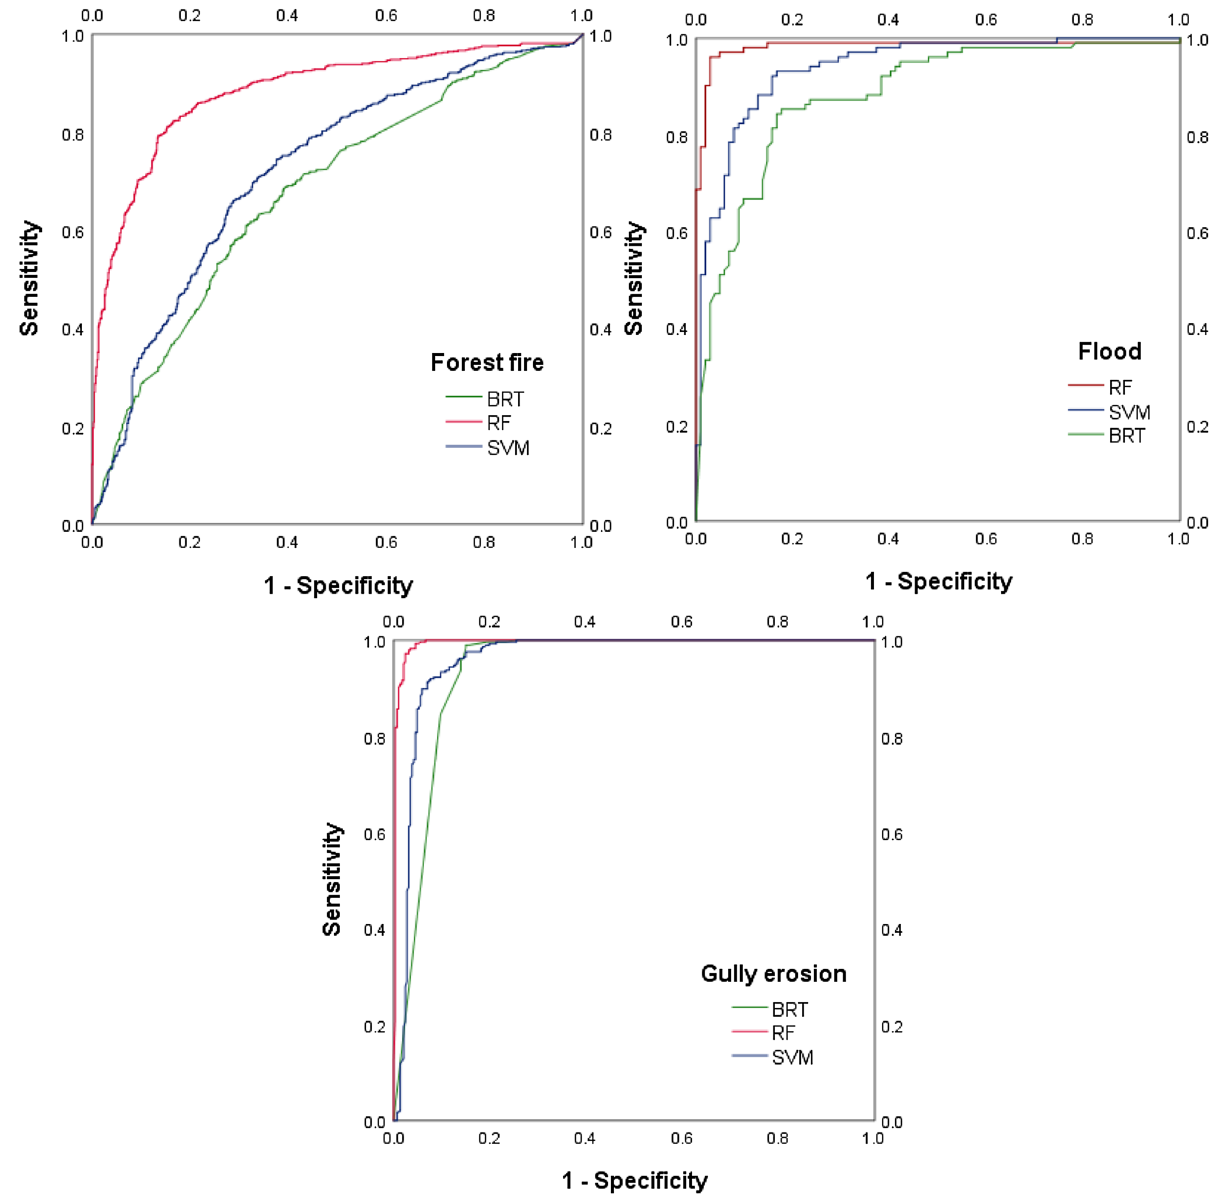
Figure 4. Validation of hazard maps using the ROC